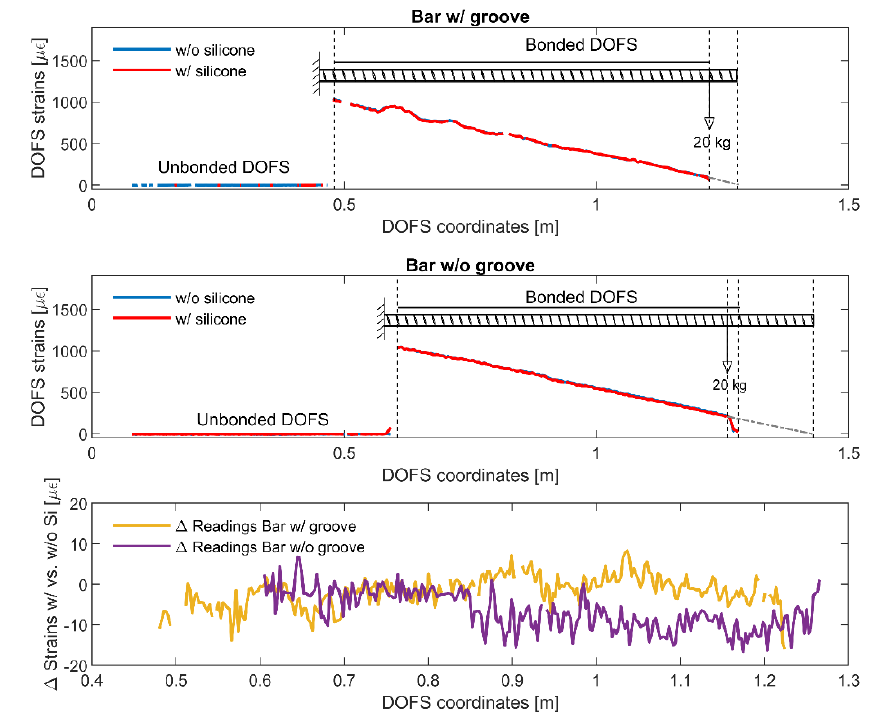
Figure 9. Strain profiles of the rebars (w/and w/o groove) under bending and the difference of values w/and w/o SI.